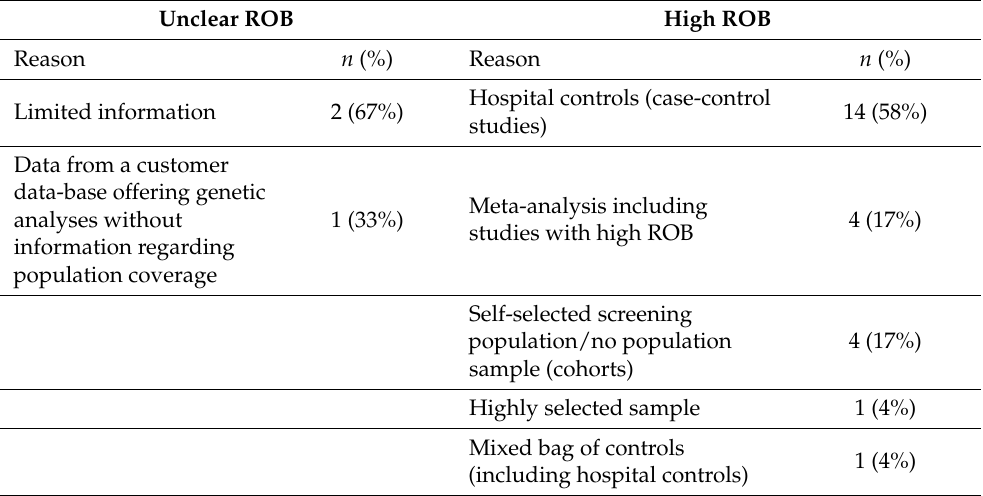
Table 1. Reasons for unclear ( n = 3) and high ( n = 24) ROB ratings in the “participants” domain.